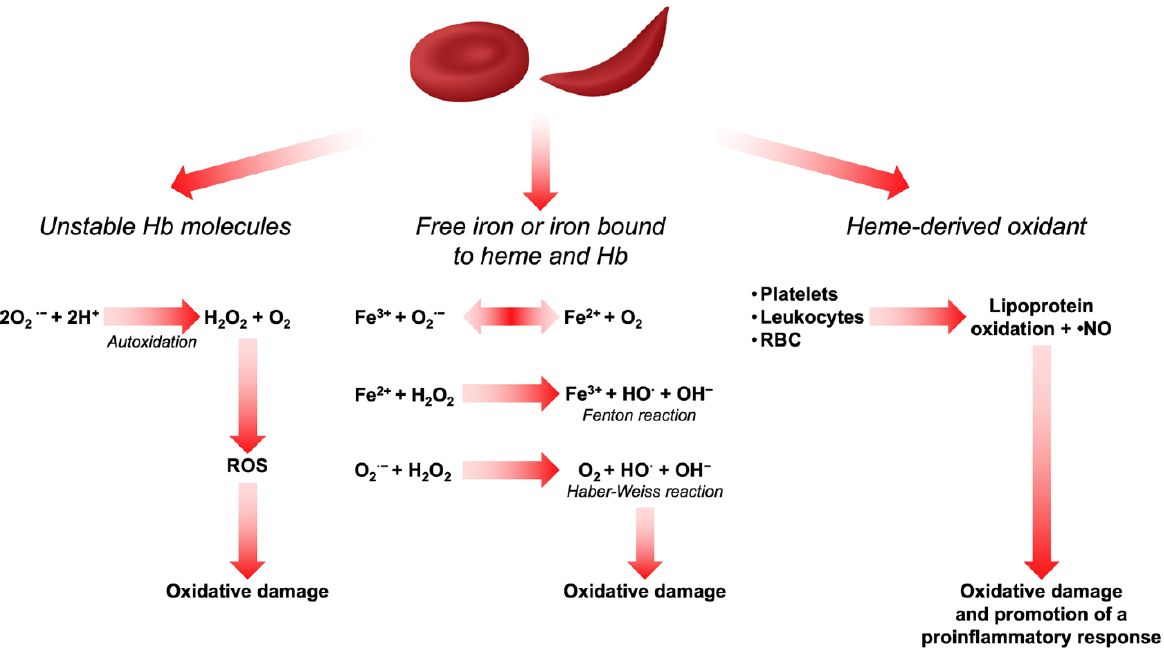
Figure 1. Sources of ROS in RBCs.